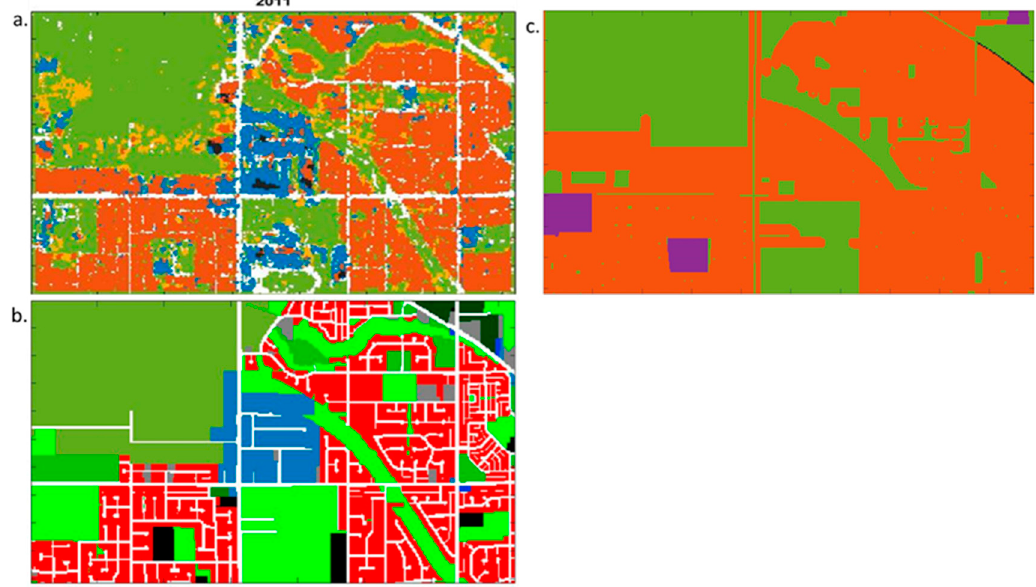
Figure 10. Comparison of the land-use classifications for the year 2011 ( a ) resulting from the proposed CNN approach for the land-use classification; ( b ) from Metro Vancouver Open Data Catalogue [50] and ( c ) from DMTI Spatial Inc